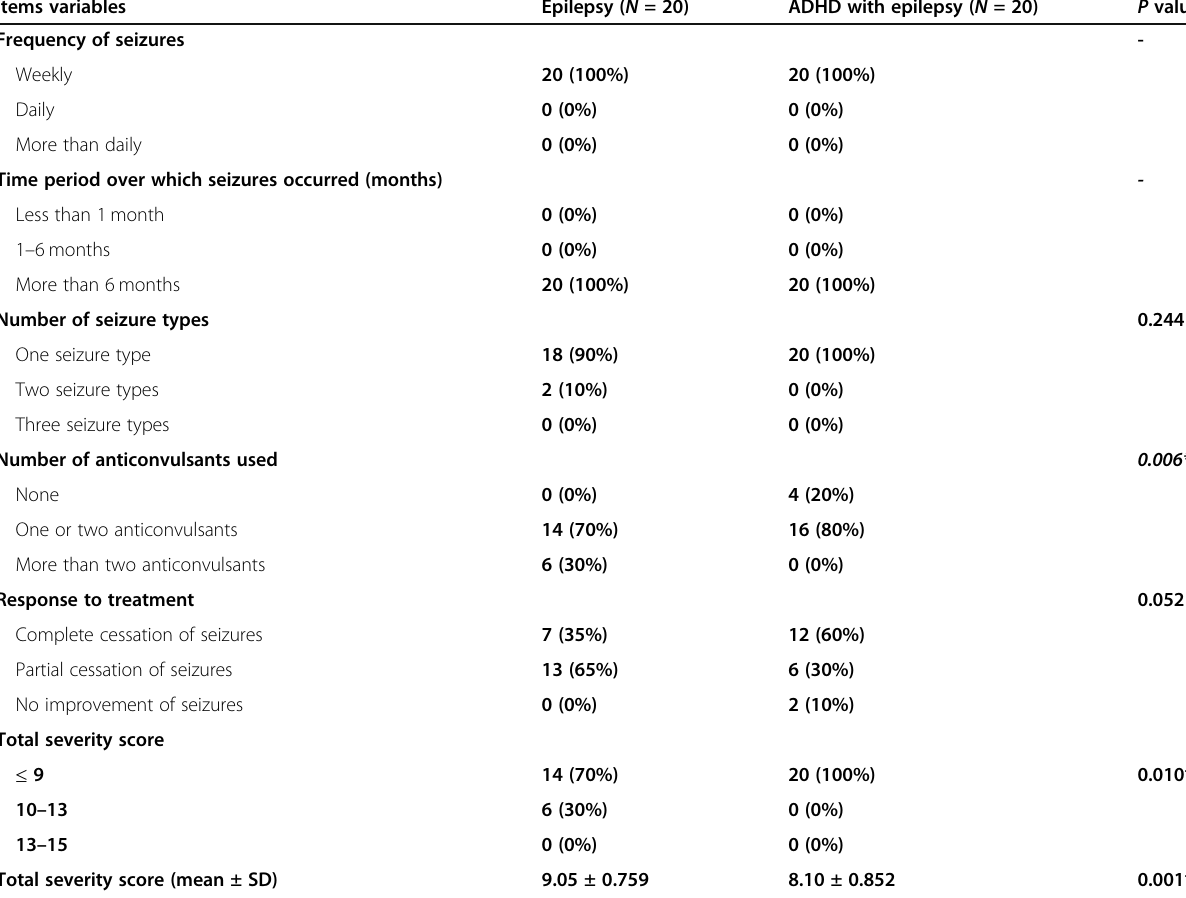
Table 3 Early Childhood Epilepsy Severity Scale (E-Chess) among the studied epilepsy groups Items